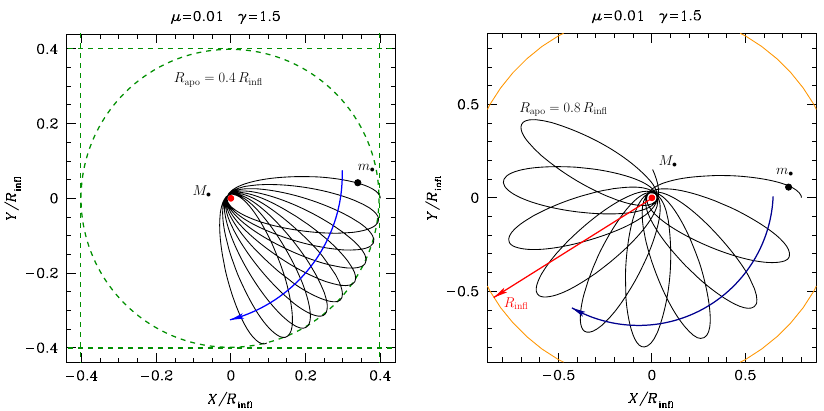
Fig. 9 Same as Fig. 8 for an apoapsis R apo = 0 . 4 , 0 . 8 R infl and a velocity of the CO of 0 . 2 V circ , with V circ the circular